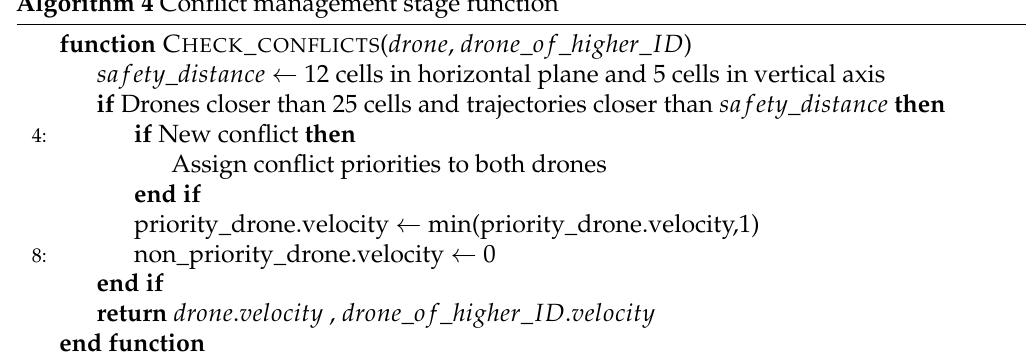
Algorithm 4 Conflict management stage